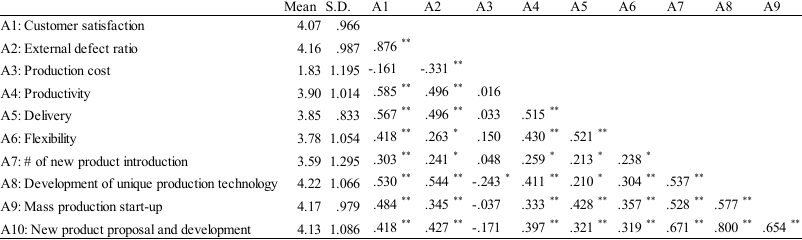
Table 1. Mean, S.D., and correlations of the items of competitiveness